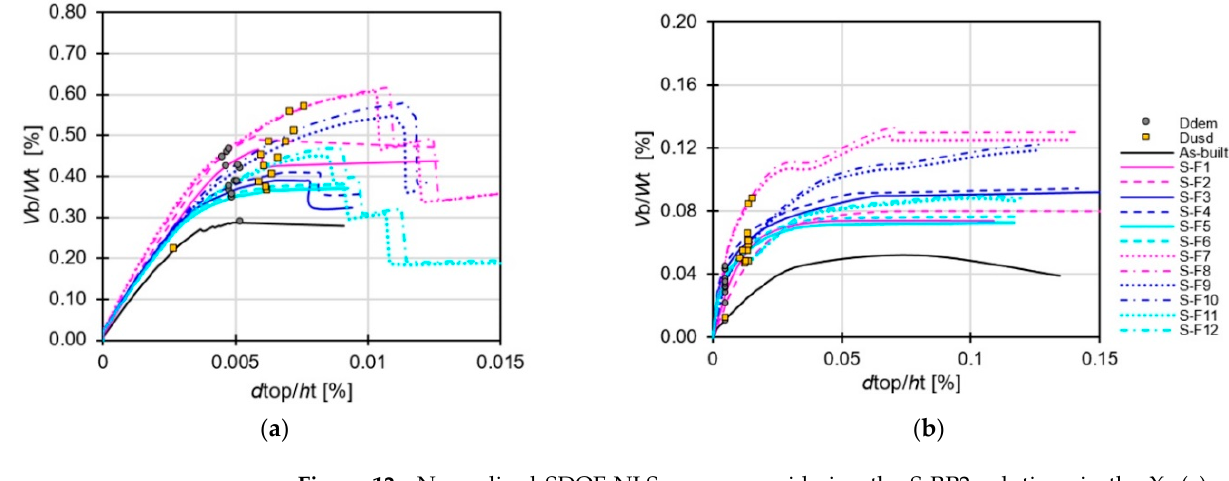
Figure 12. Normalised SDOF-NLS curves considering the S-RP2 solutions in the X- ( a ) and Y- ( b ) direction.